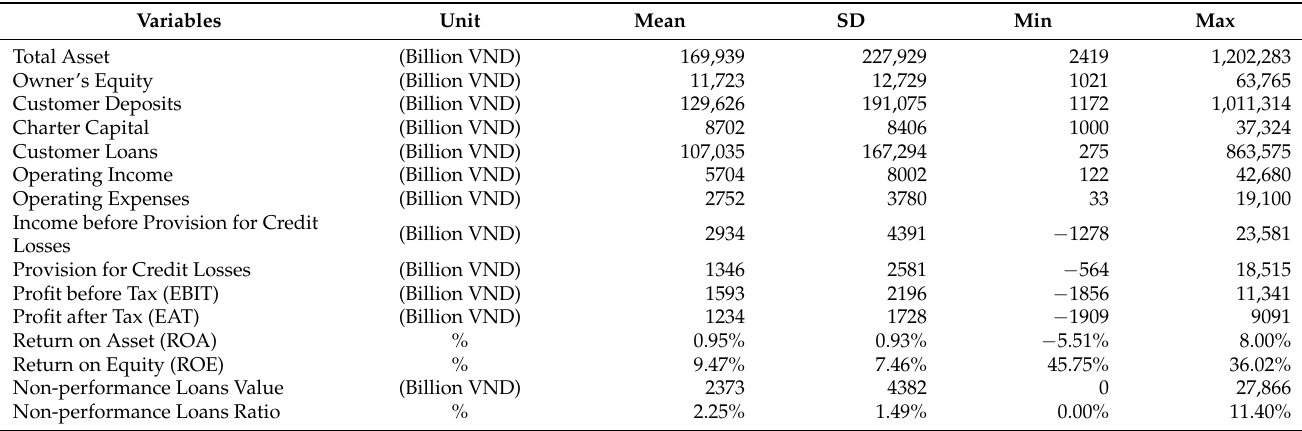
Table A2. Summary data information for the sample banks (for the period 2008 to 2017) used to track bank trajectory